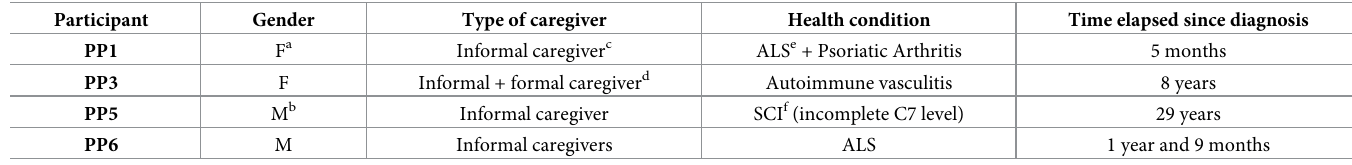
Table 1. Data of participants who used the